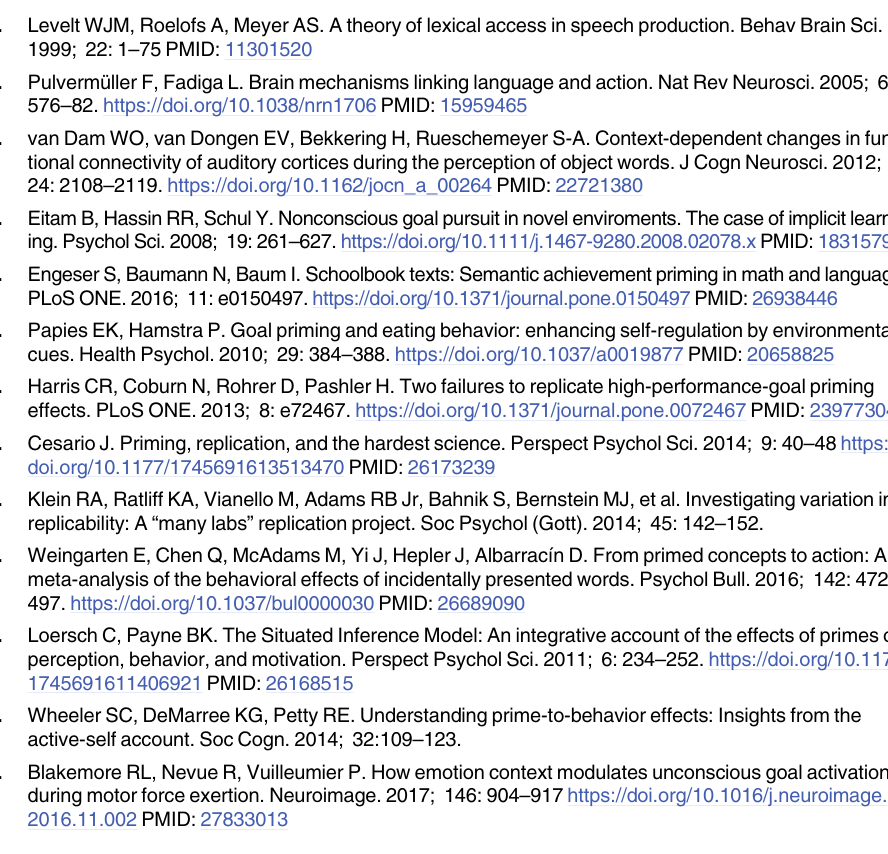
S1 Table. Stimuli used in the experiment (participants were presented the German